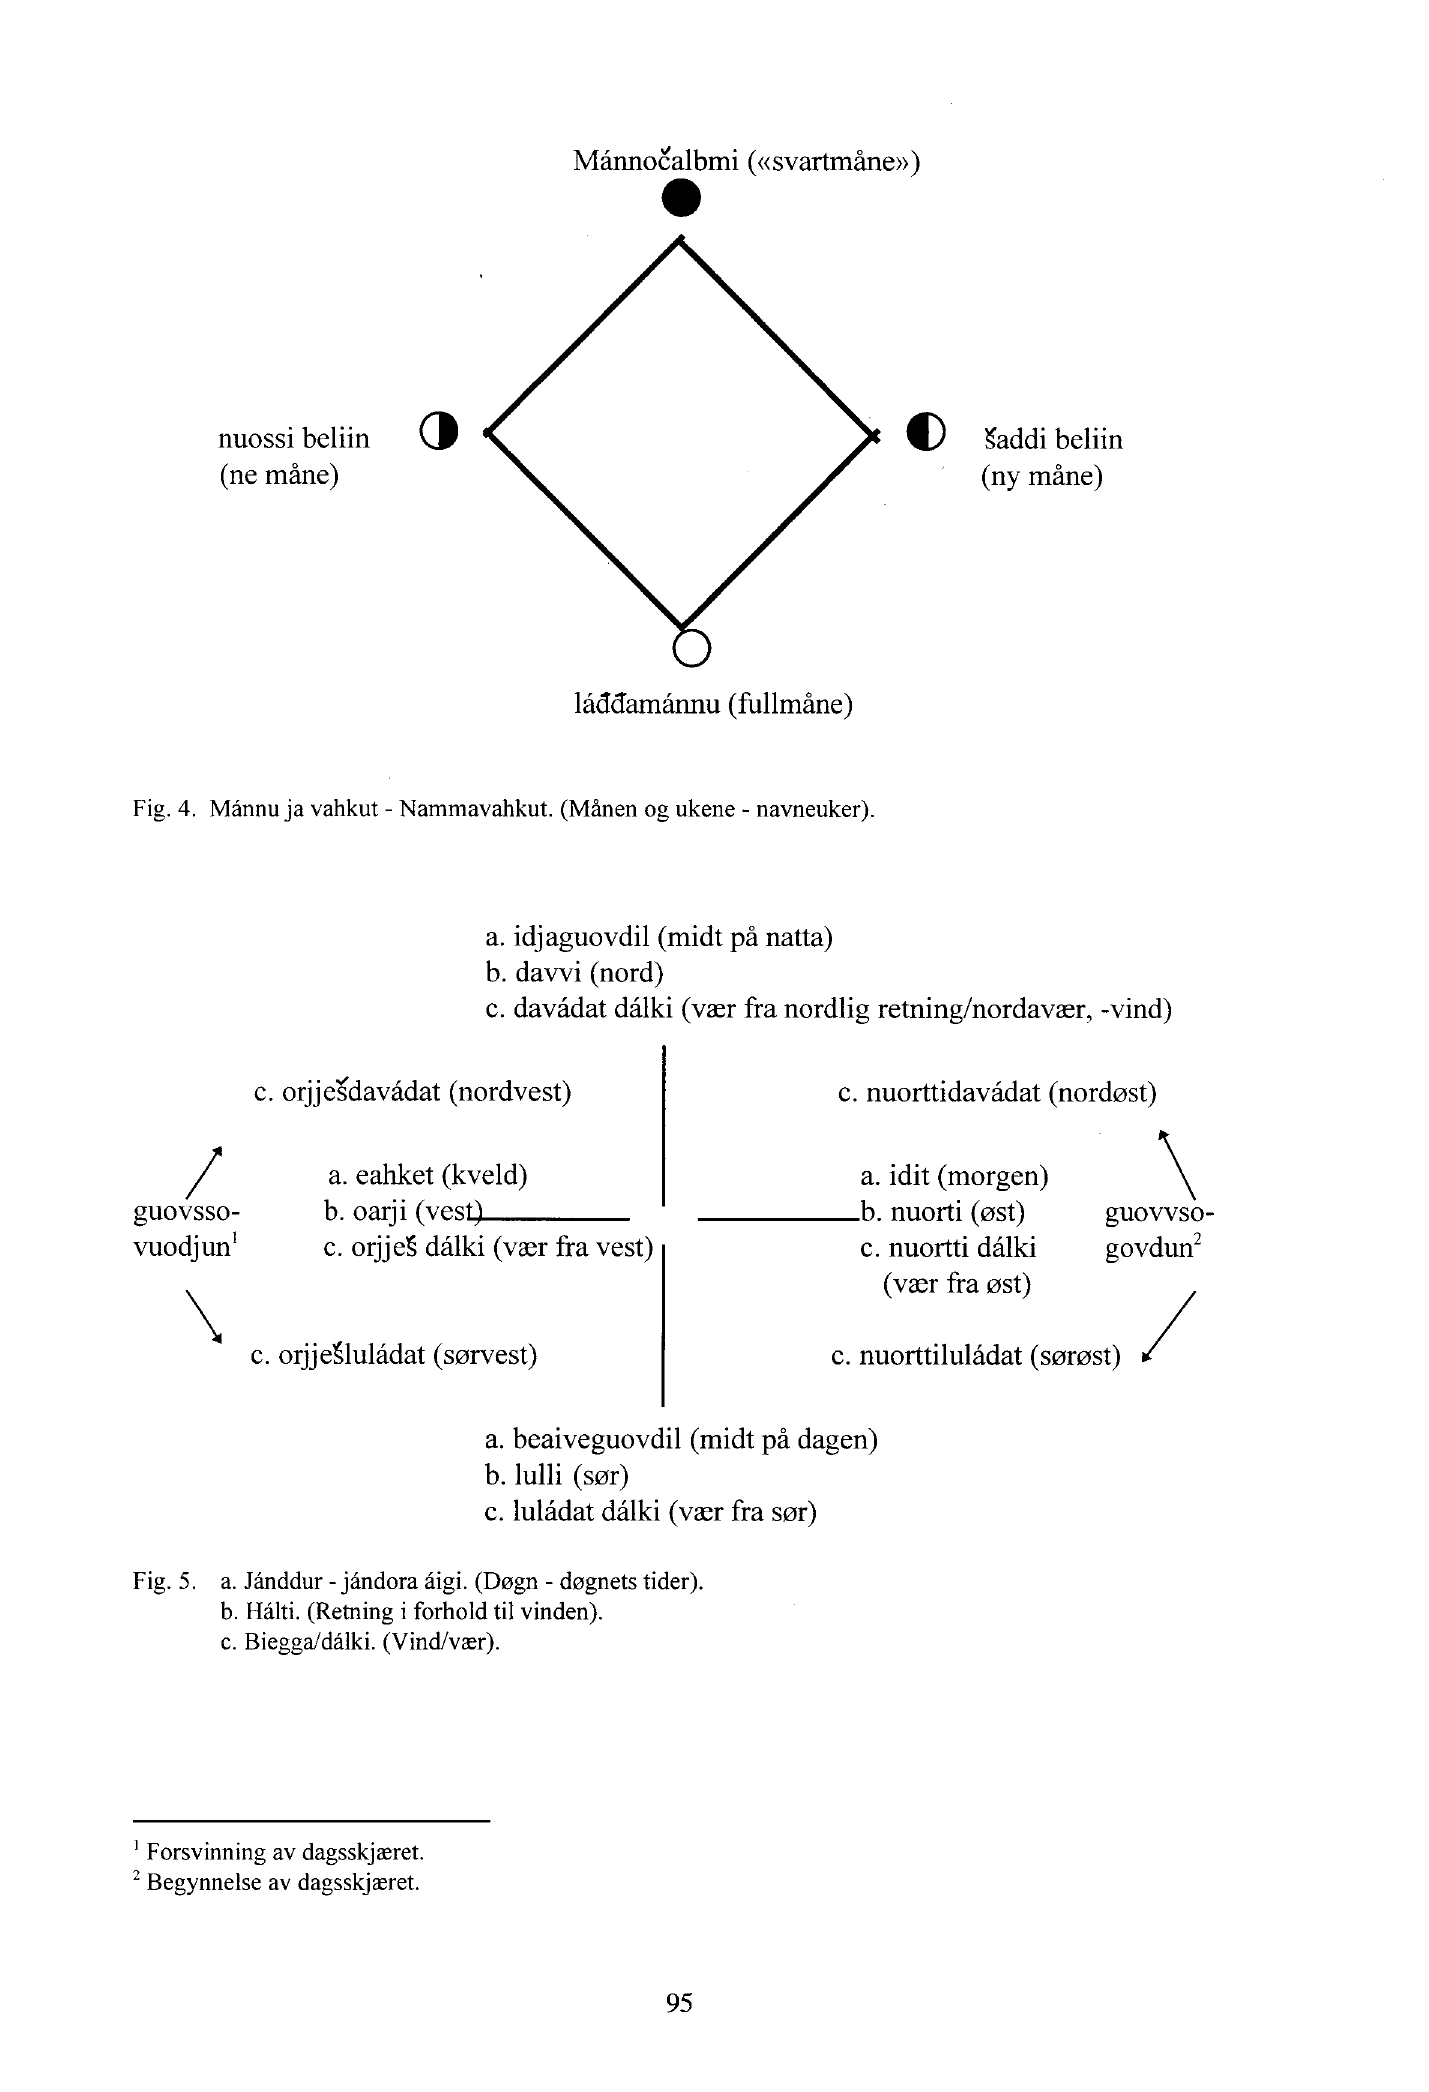
Fig. 5. a. Jånddur - jåndora åigi. (Døgn - døgnets tider). b. Haiti. (Retning i forhold til vinden). c. Biegga/dålki.